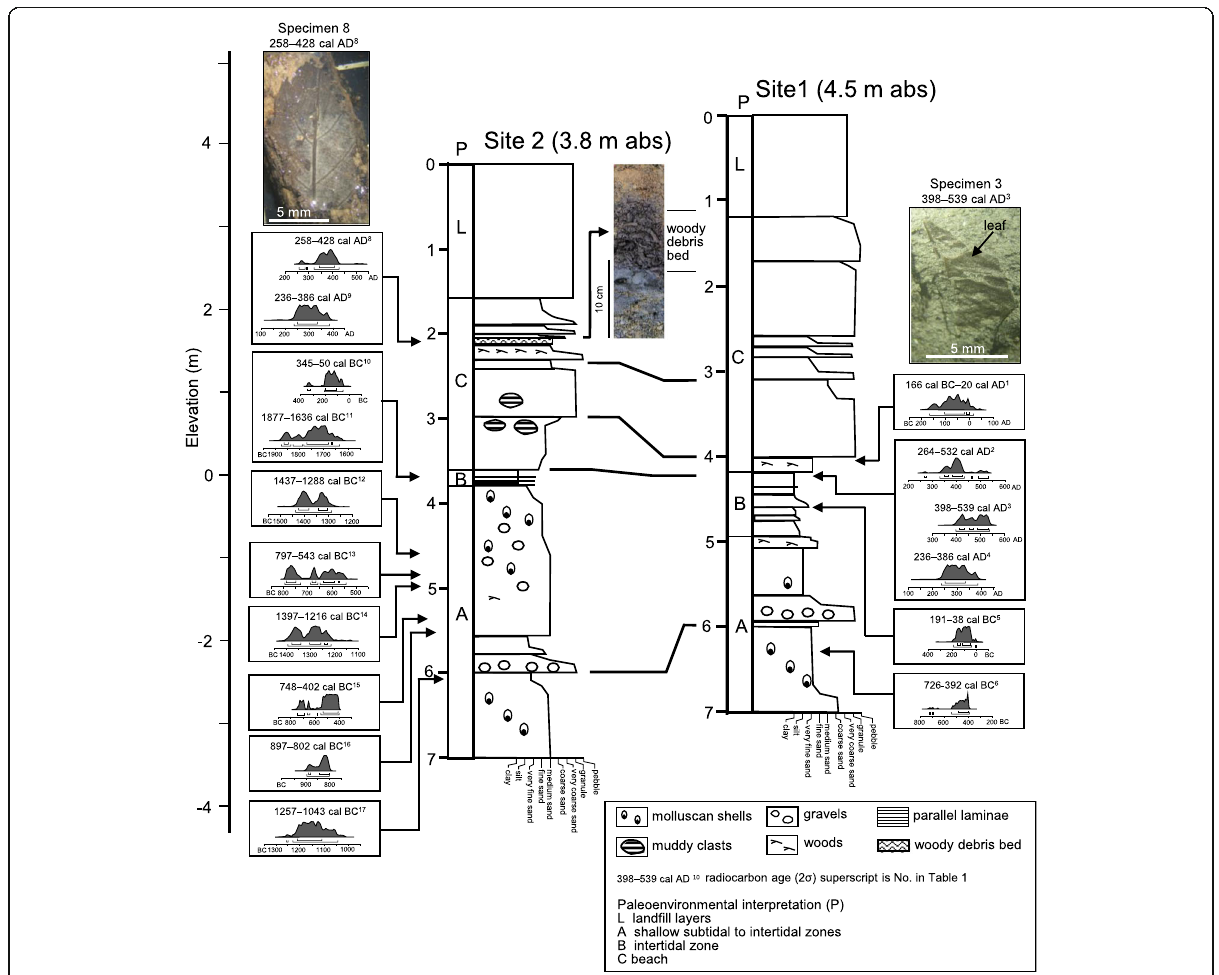
Fig. 5 Columnar sections of two sediment cores collected at the study area, showing two specimens of leaf materials (specimens 3 and